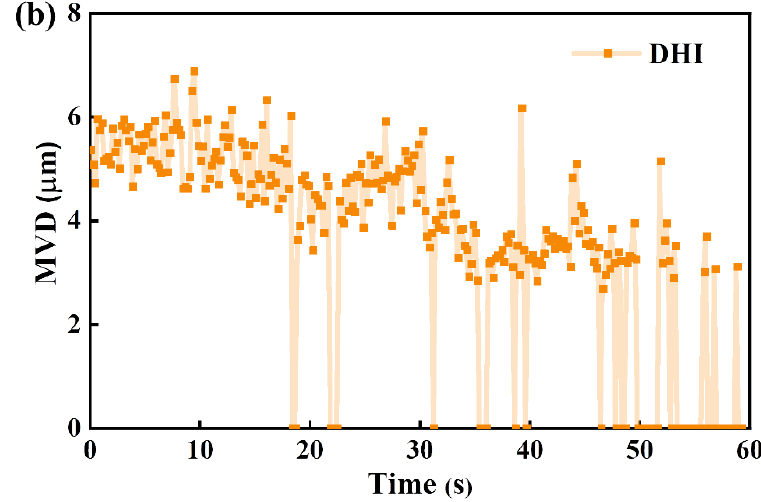
Figure 5. Comparison of DHI and fog monitor in relation to MVD during the last 60 s of the cloud processes. ( a ) The sampling frequency of both DHI and fog monitor is 1 Hz. ( b ) The MVD results of DHI with sampling frequency of 5 Hz.